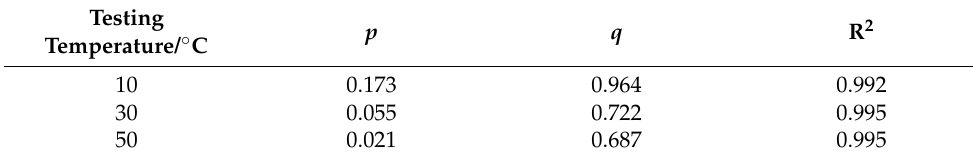
Figure 13. The relation curve between creep damage value and damage strain of asphalt mixture under different stress levels at ( a ) 10 °C, ( b ) 30 °C, and ( c ) 50 °C. Table 5. The parameters of damage evolution